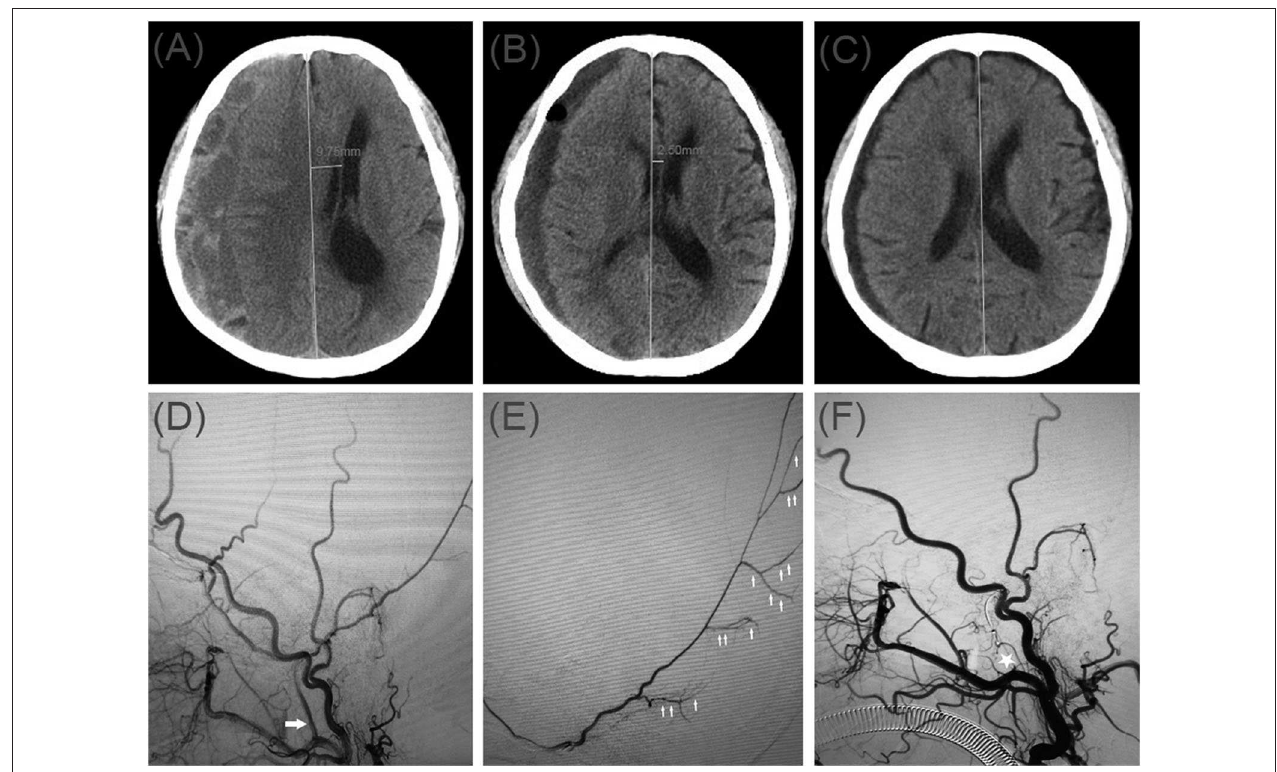
FIGURE 3 | (A) Brain computed tomographic hematoma images for patient 3 before treatment (midline shift: 9.75mm). (B) Brain CT was repeated on postoperative day 12 (midline shift: 2.50mm). (C) Follow-up brain CT was performed at 58 days. (D) Pre-operative DSA presented abnormal MMA (Large arrow). (E) Intra-operative DSA showed contrast agent extravasation or cotton wool-like staining (Small arrow). (F) Postoperative DSA found that the MMA disappeared